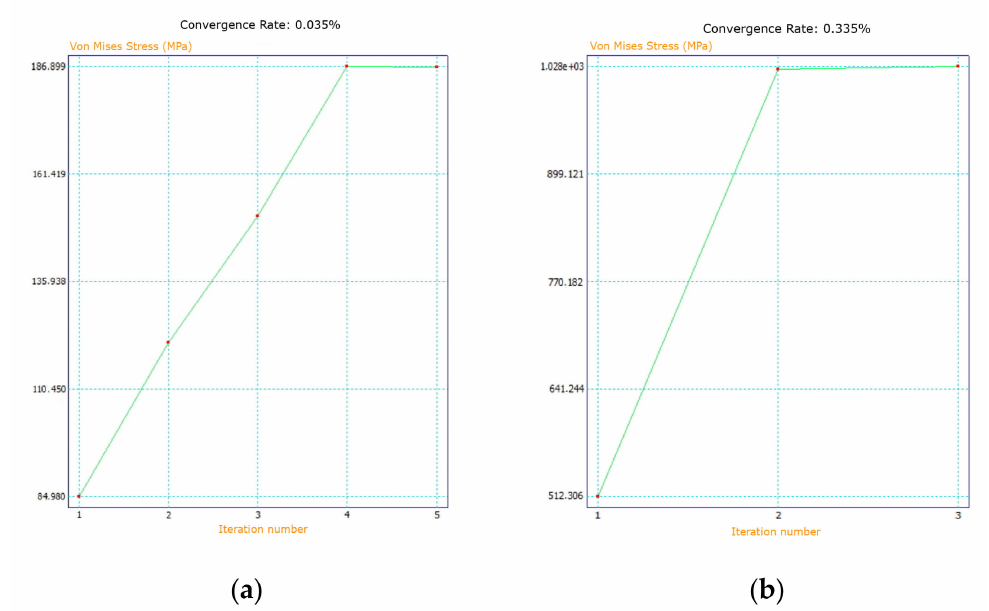
Figure 17. Convergence curve: ( a ) blockage situation and ( b ) braking